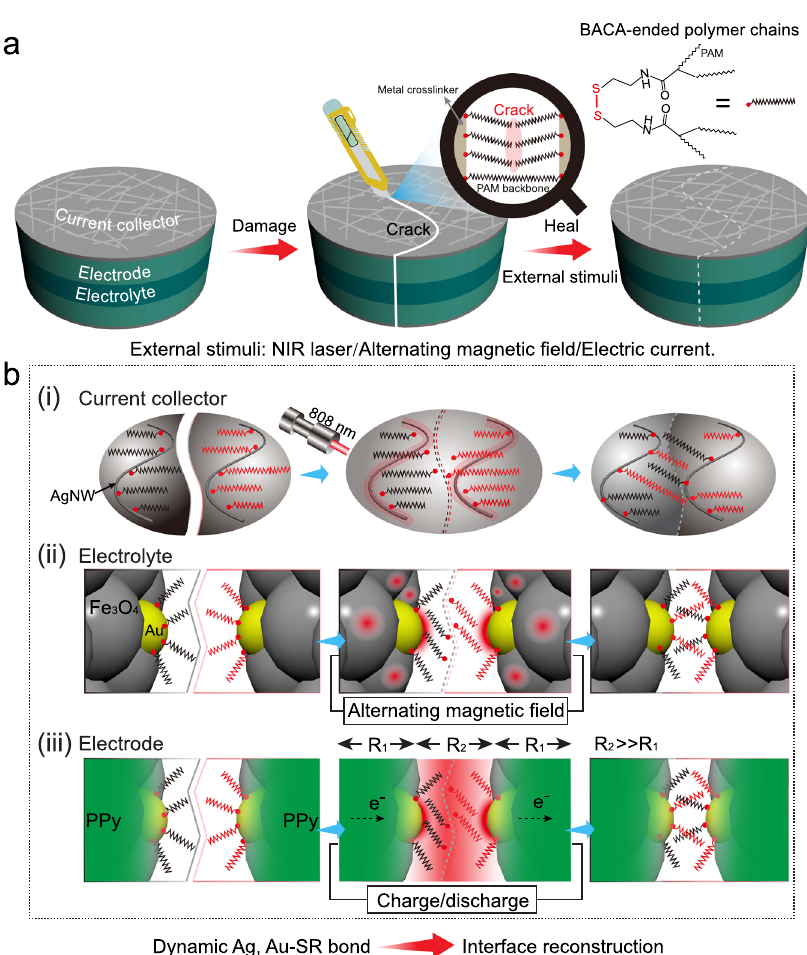
Fig. 4 Schematic illustrations of self-healing mechanism of supercapacitor. a Scheme of the self-healing process. b Schematic illustrations for the healing mechanism of the damaged supercapacitor under the external stimuli, taking optical healing of current collector, magnetic healing of electrolyte, and electrical healing of electrode as examples. The dynamic Ag, Au – SR bond-induced interface reconstruction results in the healing of the crack region under the photothermal, magneto-thermal, and galvano-thermal